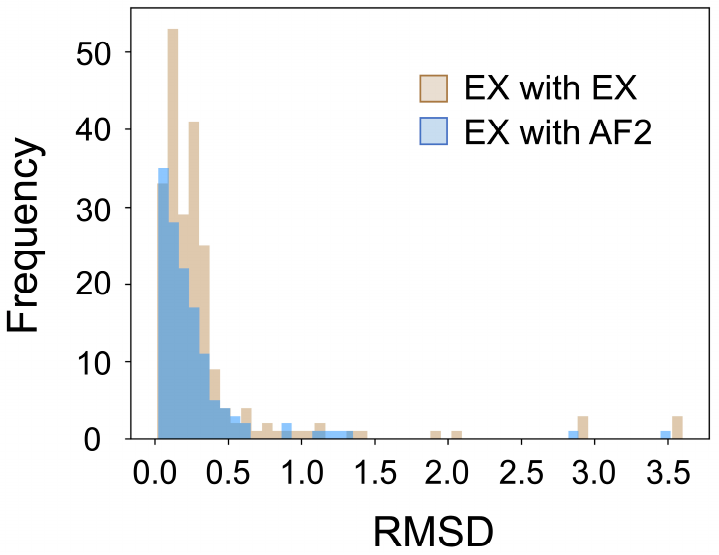
Figure 8. Comparing the experimental range of accuracy to the accuracy of AlphaFold 2 predictions with RMSD. The experimental range of accuracy has an average RMSD of 0.35 Å, and the accuracy of AlphaFold 2 prediction against the experimentally predicted structures has an average RMSD of 0.28